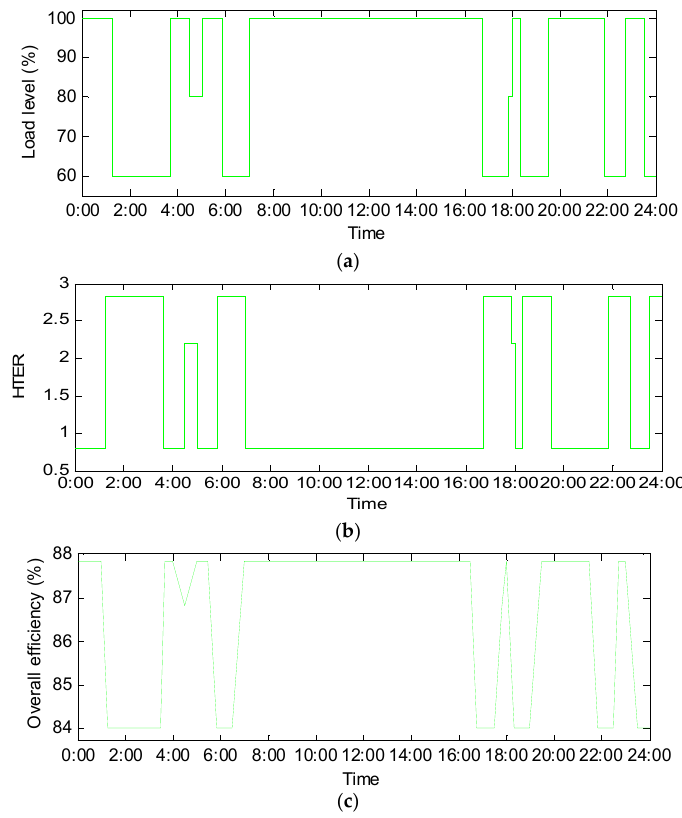
Figure 11. Optimal operation points of CHP in real time: ( a ) optimal loading level of CHP in real time; ( b ) optimal HTER of CHP in real time; ( c ) optimal efficiency of CHP in real time.